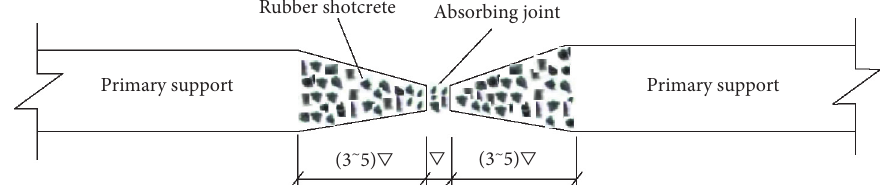
Figure 17: Structural sketch of absorbing joint in primary support.